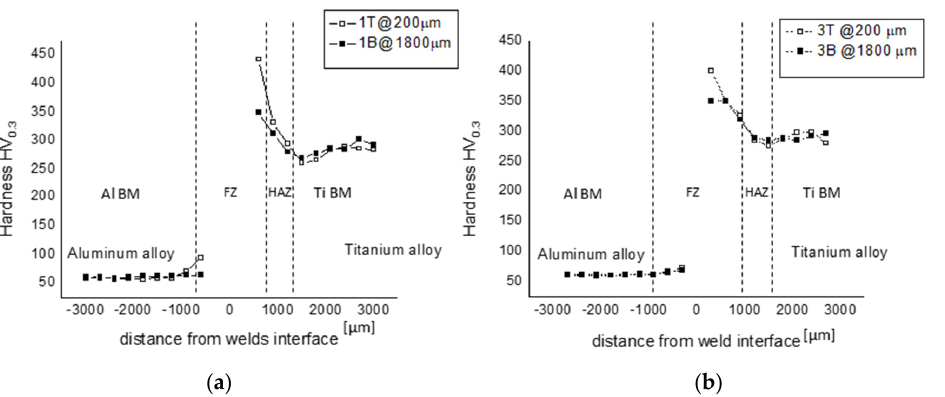
Figure 11. Micro hardness profile as a function of distance from the weld interface at 200 and 1800 μ m from upper surface for 1T and 1B weld ( a ) and 3T and 3B welds ( b ).